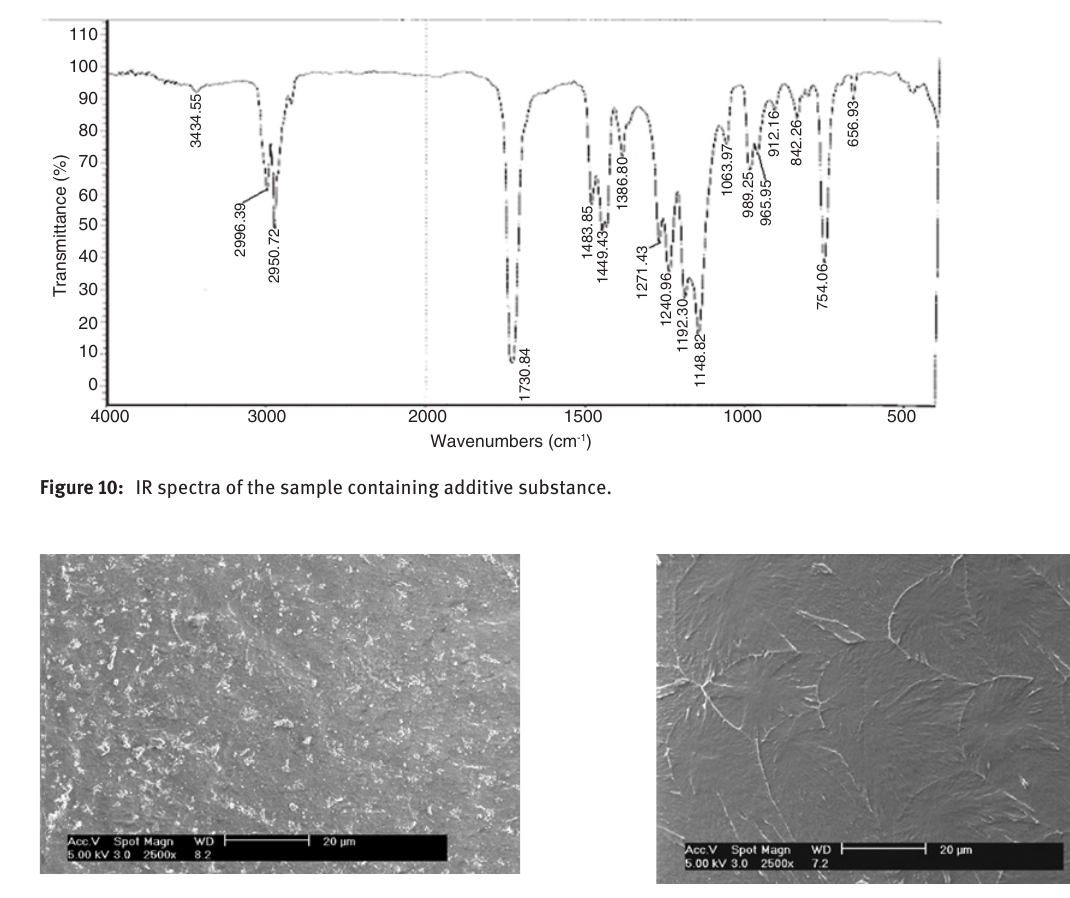
Figure 12: SEM microstructure of the sample containing additive